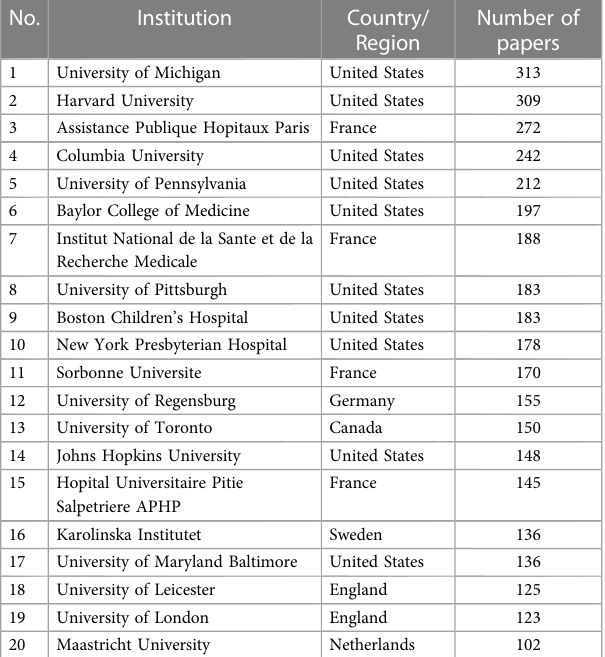
TABLE 3 Top 20 institutions in terms of number of ECMO research papers. No.